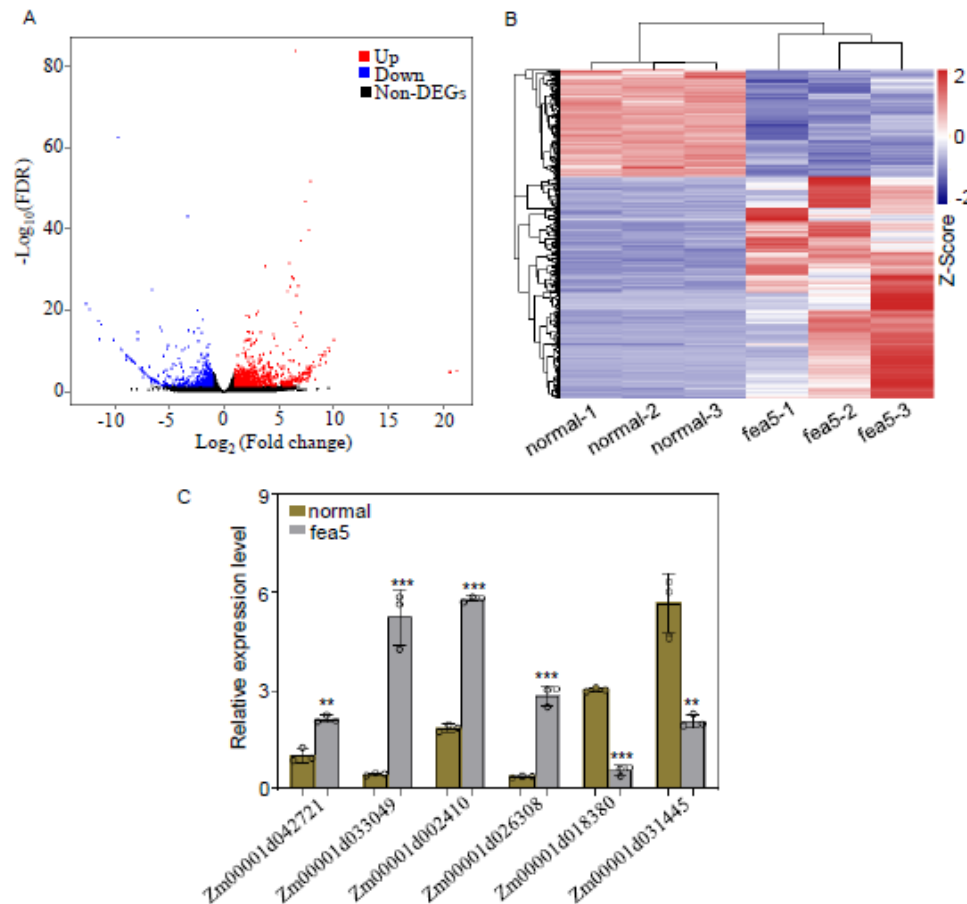
Figure 4. The differentially expressed genes (DEGs) between normal and fea5 plants. ( A ) Gene expression classification of DEGs. Blue and red dots indicate down- and up-regulated genes (significance level: FDR < 0.05, Log2FoldChange >1), respectively. ( B ) Heat map of the DEGs between normal and fea5 plants. ( C ) The selected genes were verified by RT-qPCR with three replicates per gene. Values are represented as means ± SD, ** p < 0.01; *** p < 0.001 (Student’s t -test). Gene Ontology (GO) terms and Kyoto Encyclopedia of Genes and Genomes (KEGG) pathways were used to functionally annotate the DEGs. The DEGs could be divided into three main GO categories: biological process, molecular function, and cellular component.